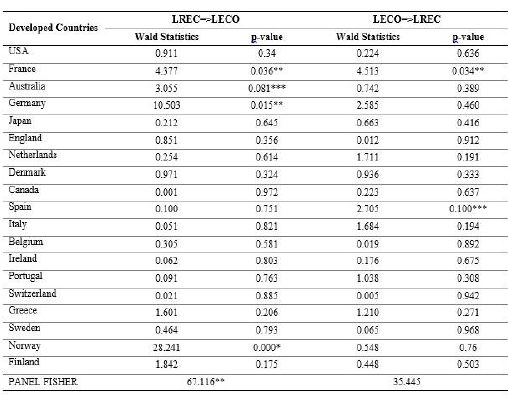
Table 10: Emirmahmutoğlu and Köse Panel Causality Test Analysis Results